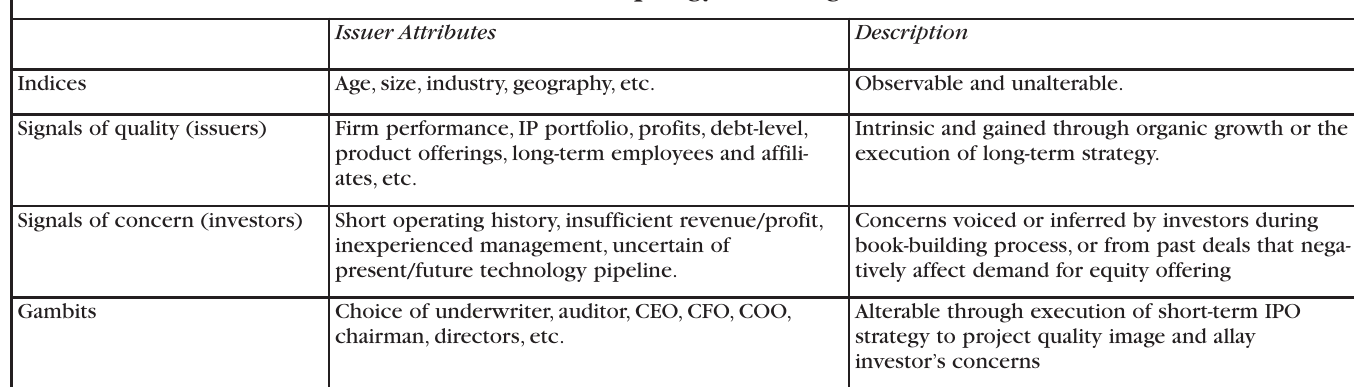
Table 1. A Topology of IPO